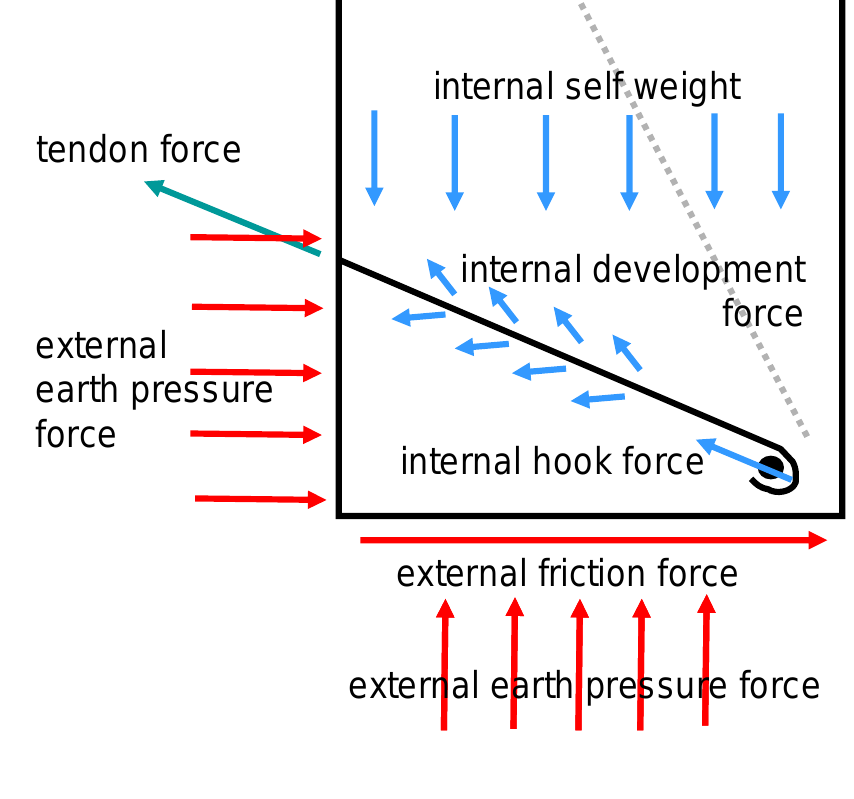
Figure 17. Illustration showing internal and external forces acting on concrete anchor